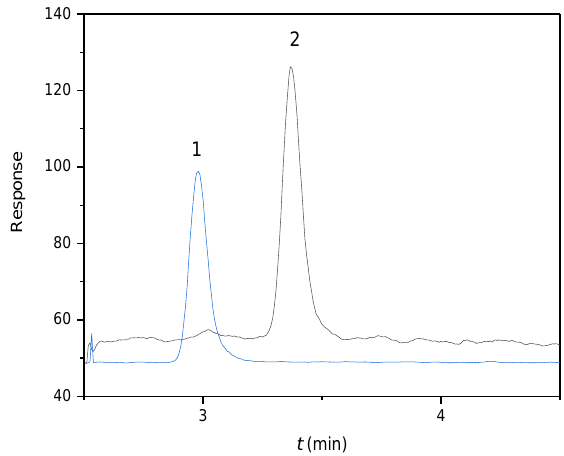
Figure 1. MRM chromatograms of (1) E2-d 3 as an internal standard (IS) at a concentration of 25 μg/L ( t r = 3.0 min, MRM transition 258 → 159) and (2) αE2 as an analyte at a concentration of 20 μg/L ( t r = 3.4 min, MRM transition 255 → 159) in capacitating M2 medium. Experimental conditions: 50/50 ( v / v ) acetonitrile/water, both containing 0.1% formic acid, flow rate 0.3 mL/min, sample injected 10 μL.